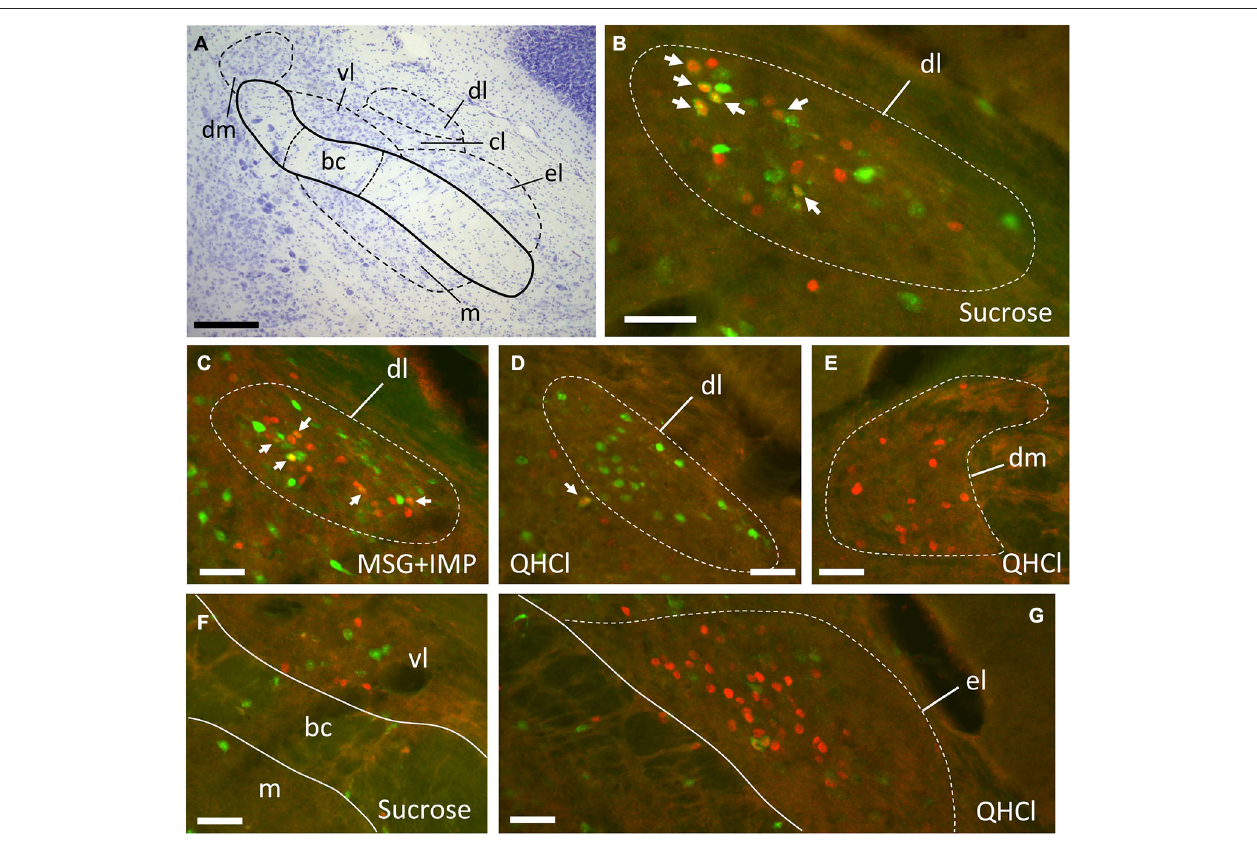
seen (arrows). (C) The stimulus mixture MSG + IMP also evokes robust FLI in cells in this region, and double-labeled cells are present (arrows). (D) QHCl did not evoke FLI in cells in the dl. However, QHCl evoked robust FLI in cells in the dm (E) and el (G) , but with few double-labeled neurons. (F) Sucrose-evoked FLI and FG cells in the gustatory waist region of the PbN. Scale bars = 100 µ m for (A) , 50 µ m for all other images (B–F)